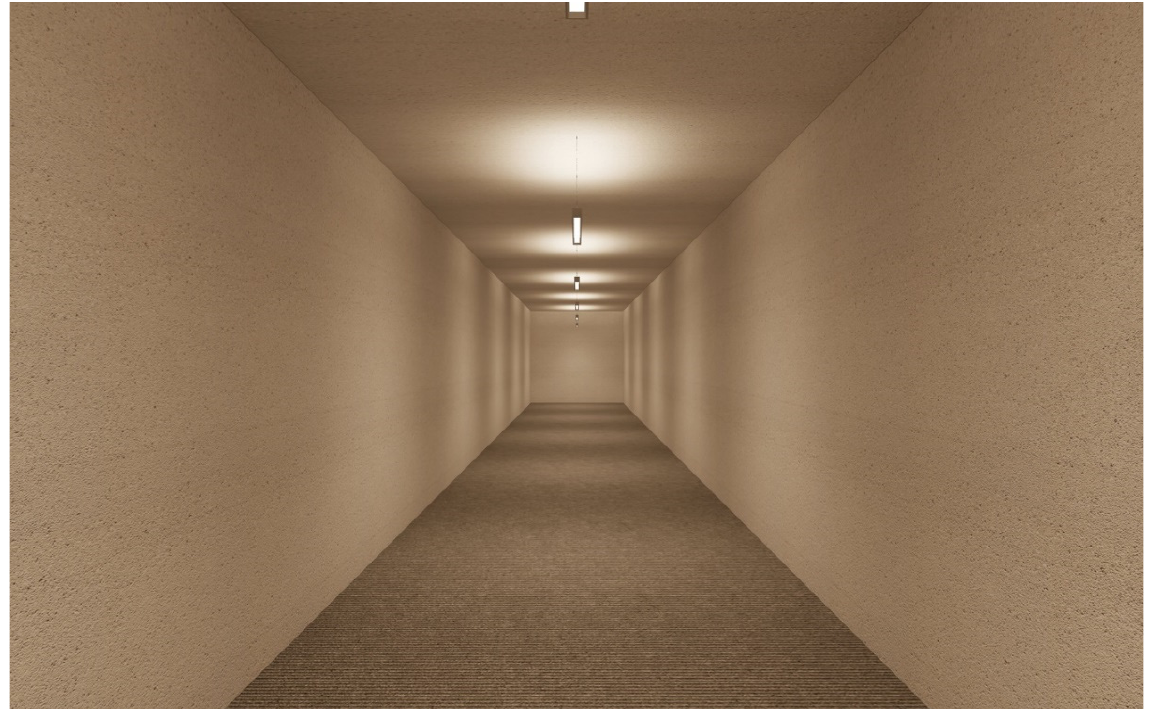
Figure 11. Computer simulation of corridor lighting for variant 8.